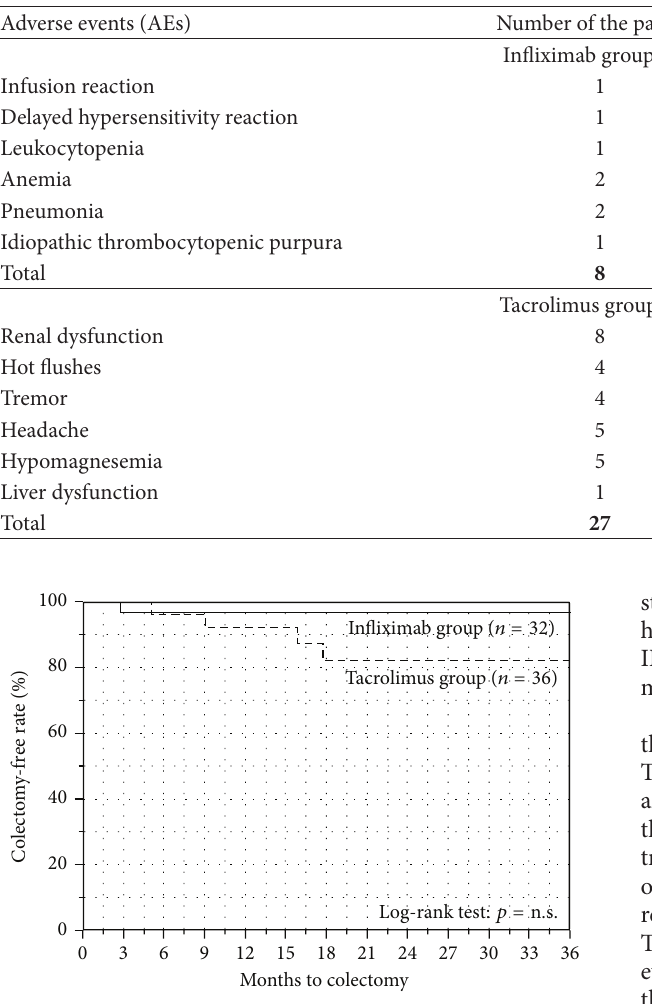
Figure 6: Kaplan-Meier plots for colectomy-free survival. The colectomy-free survival rate at 6, 12, and 18 months was 97%, 97%, and 97% in the IFX group (𝑛 = 32) and 96%, 92%, and 82% in the Tac group (𝑛 = 36) , respectively. There was no significant difference between both